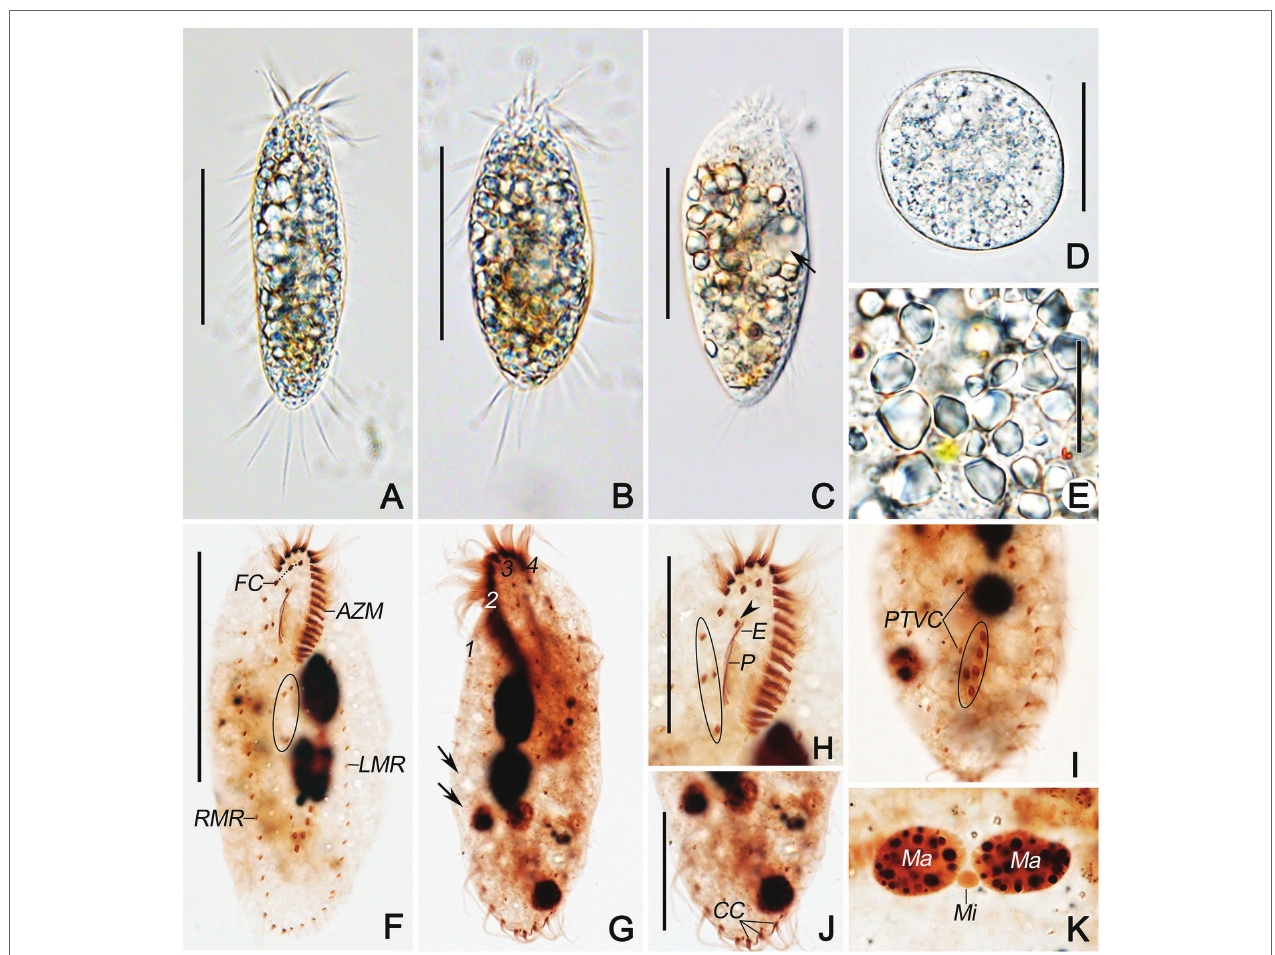
FIGURE 2 | Photomicrographs of Quadristicha subtropica n. sp. from life (A–E) and after protargol staining (F–K) . (A,B) Ventral views of representative individuals to show different body shapes. (C) Ventral view, to denote contractile vacuole (arrow). (D) Resting cyst. (E) Crystals. (F,H) Ventral views to demonstrate the ciliature. Arrowhead marks the buccal cirrus; circle in F and H demonstrates the postoral ventral and the frontoventral cirri, respectively. (I) Ventral view of posterior end, to show transverse cirri (circle). (G,J,K) Dorsal views to demonstrate the dorsal kineties, caudal cirri, and nuclear apparatus. Arrows in G show the gap in dorsal kinety 1. 1–4, dorsal kineties 1–4. Bars: 50 μ m (A–C) ; 30 μ m (D,H,J) ; 20 μ m (E) ; 70 μ m (F)